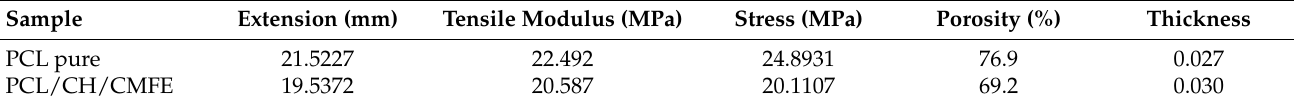
Table 2. Mechanical properties of nanofiber mesh (PCL and